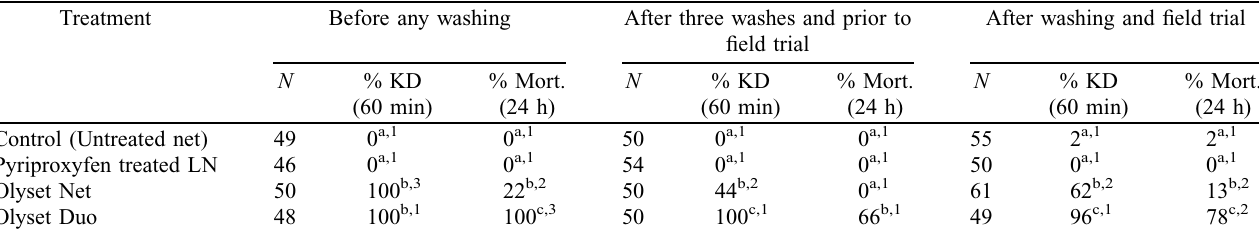
Table 1. Knockdown (KD) rate at 60 min and mortality rate of An. gambiae Kisumu strain after 3 min exposure to treated nets following WHO standard procedures (WHO 2013) run before washes (28/09/2012), after the three washes (10/10/2012), and after the trial (13/11/ 2012). Before any washing After three washes and prior